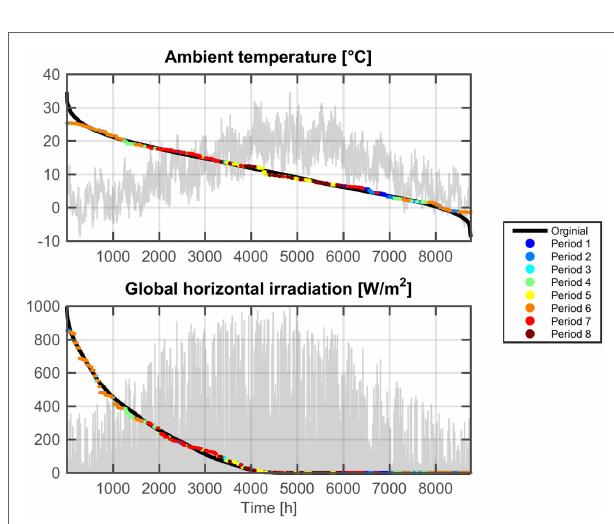
FIGURE 5 | The ambient temperature and solar irradiation DRY load duration curves (black, front) and profiles (gray, background) of Geneva-Cointrin represented by 8 typical periods